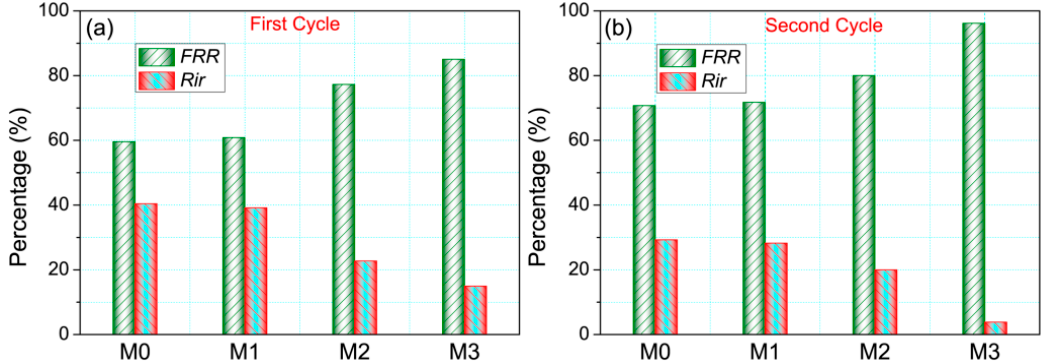
Figure 8. Irreversible membrane fouling ratio ( R ir ) and flux recovery ratio ( FRR ) of membranes in the cycle filtration. (a) and (b) represent the first and second cycle filtration, respectively.